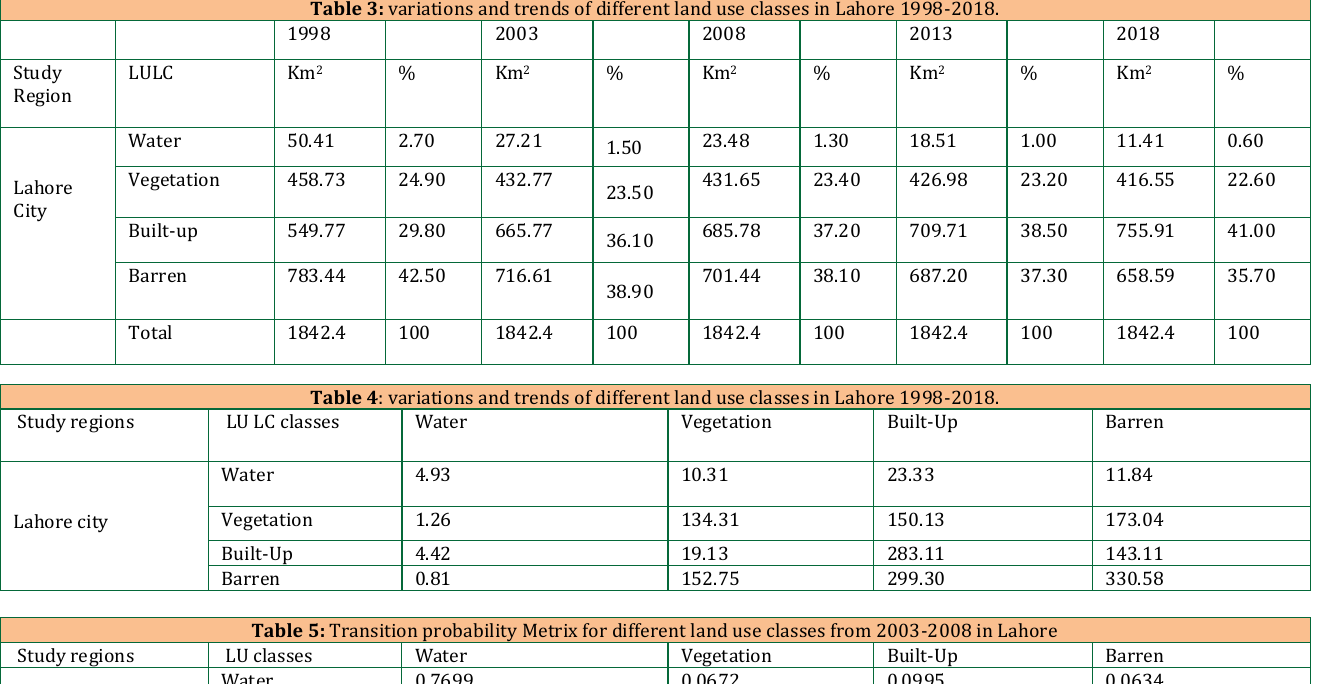
Table 5: Transition probability Metrix for different land use classes from 2003-2008 in Lahore Study